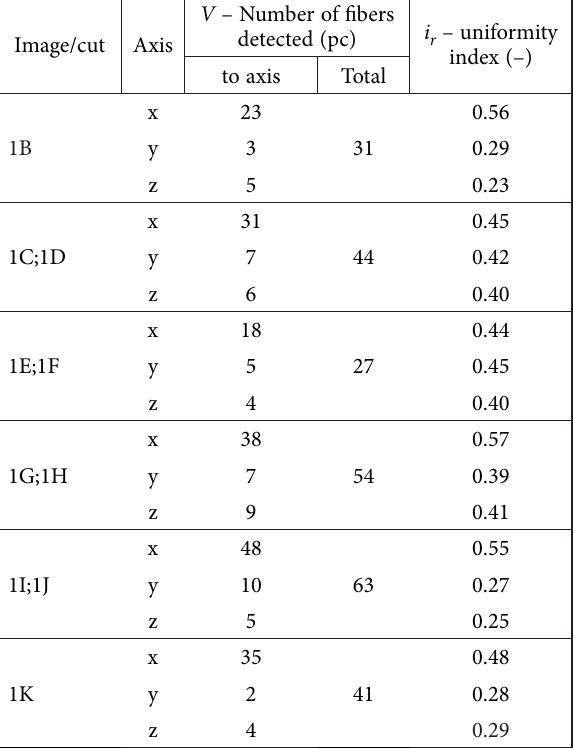
Table 6. The output table of the experimental beam sample 1